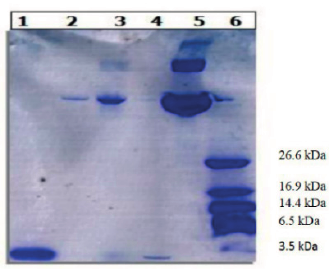
Figure 4. Tris-tricine SDS gel electrophoresis under reducing conditions.1, Pure PTH; 2, NPTH released; 3, entrapped NPTH; 4, Surface NPTH; 5, Pure BSA and 6, Molecular-weight size